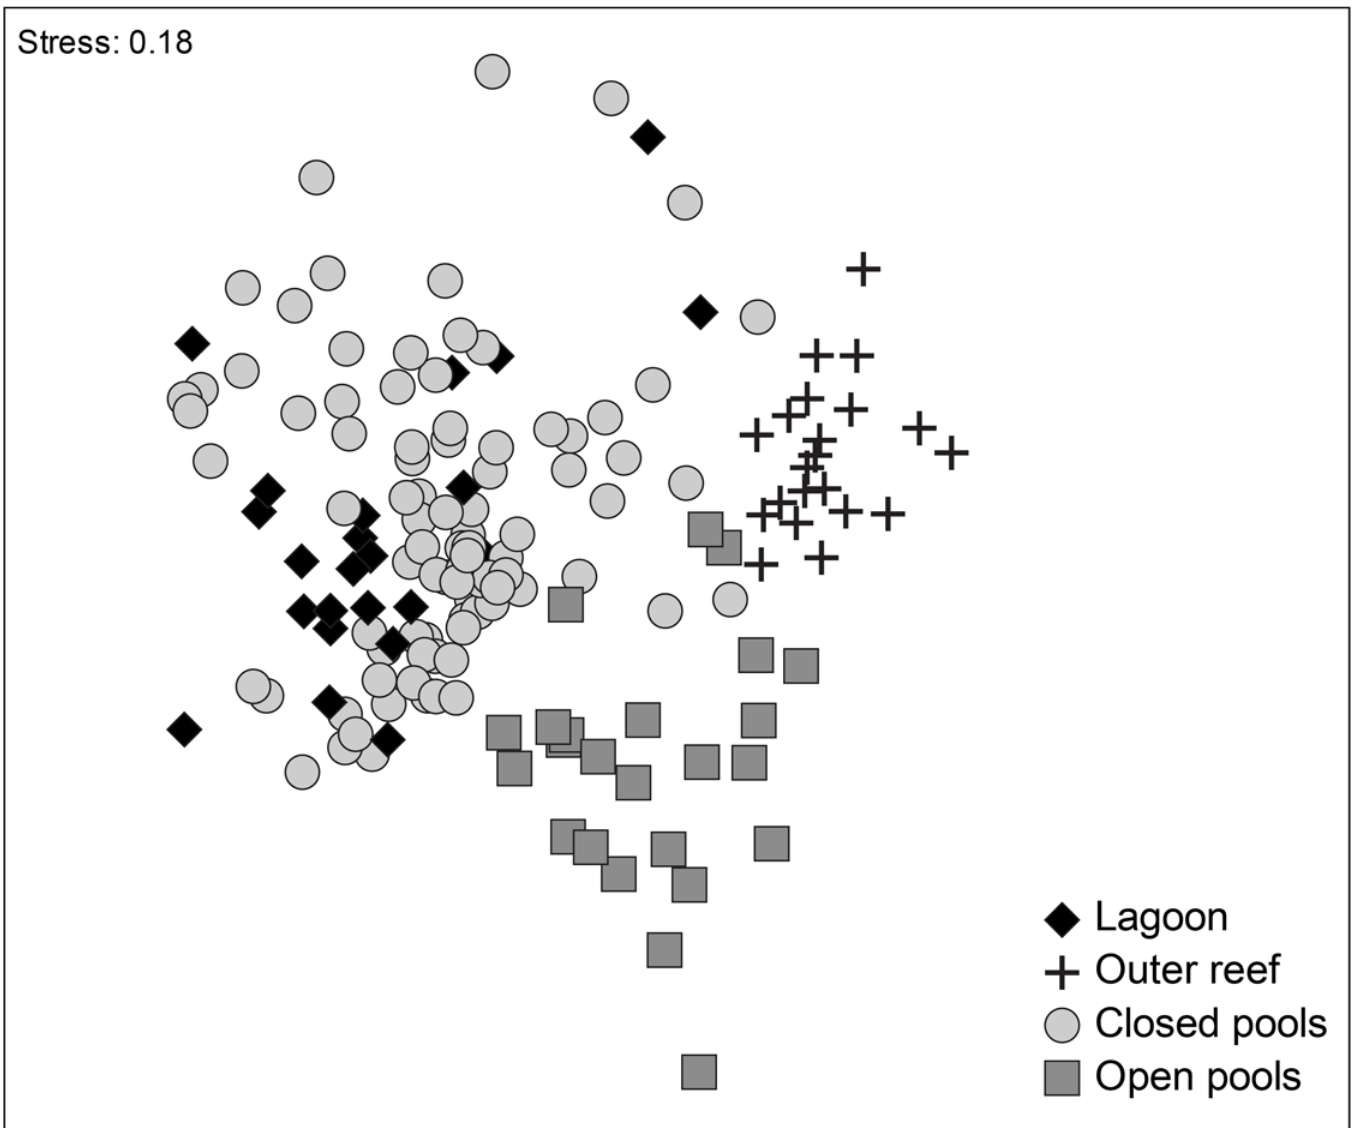
Fig 2. Multidimensional Scaling (MDS) of the composition of reef fish assemblages among different habitats based on a Bray-Curtis similarity matrix.